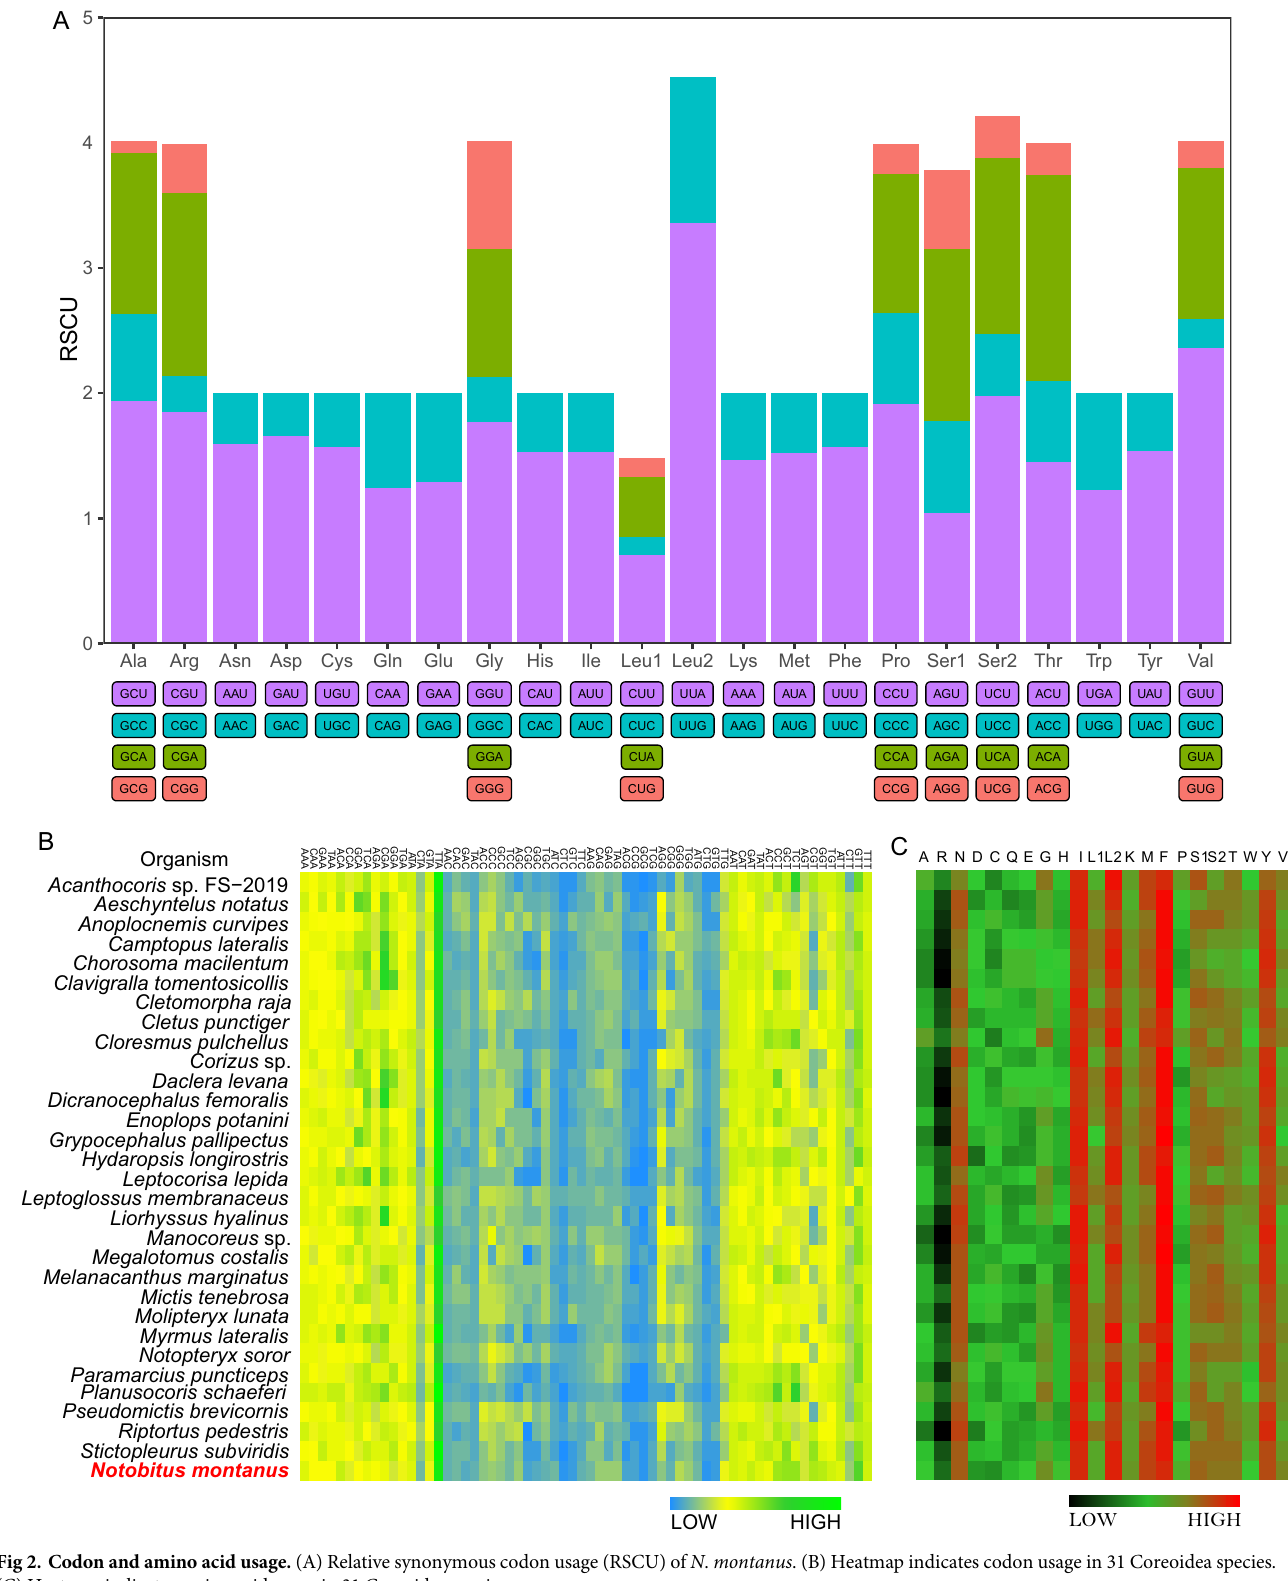
PLOS ONE | https://doi.org/10.1371/journal.pone.0281597 February 10,